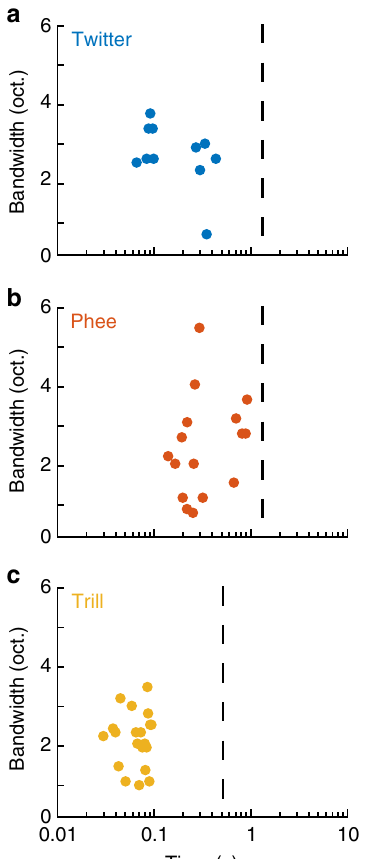
Fig. 4 MIFs are of intermediate bandwidths and lengths. Scatter plot of the distribution of all MIFs for a twitters, b phees, and c trills as a function of their bandwidth and temporal integration period. Dashed line indicates the mean length of each call type. Colors are: blue — twitter, red — phee, yellow —